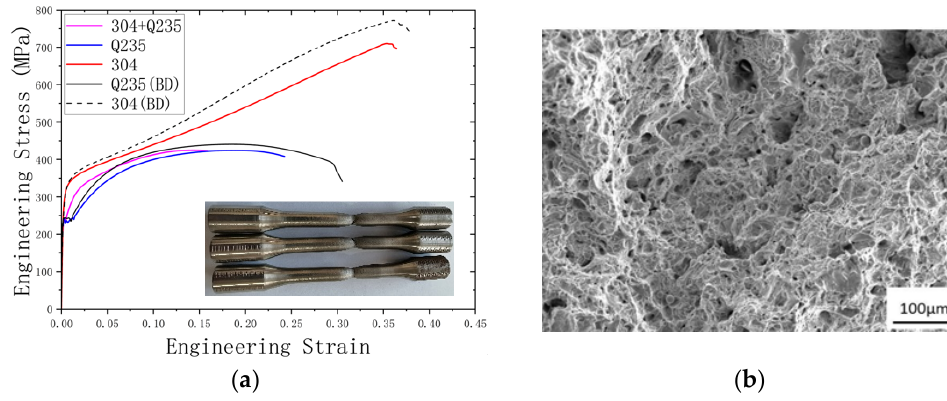
Figure 6. Tensile properties of a press-bonded Q235/304 joint: ( a ) the engineering stress-strain curves; ( b ) the SEM fractography of the Q235/304 joint.